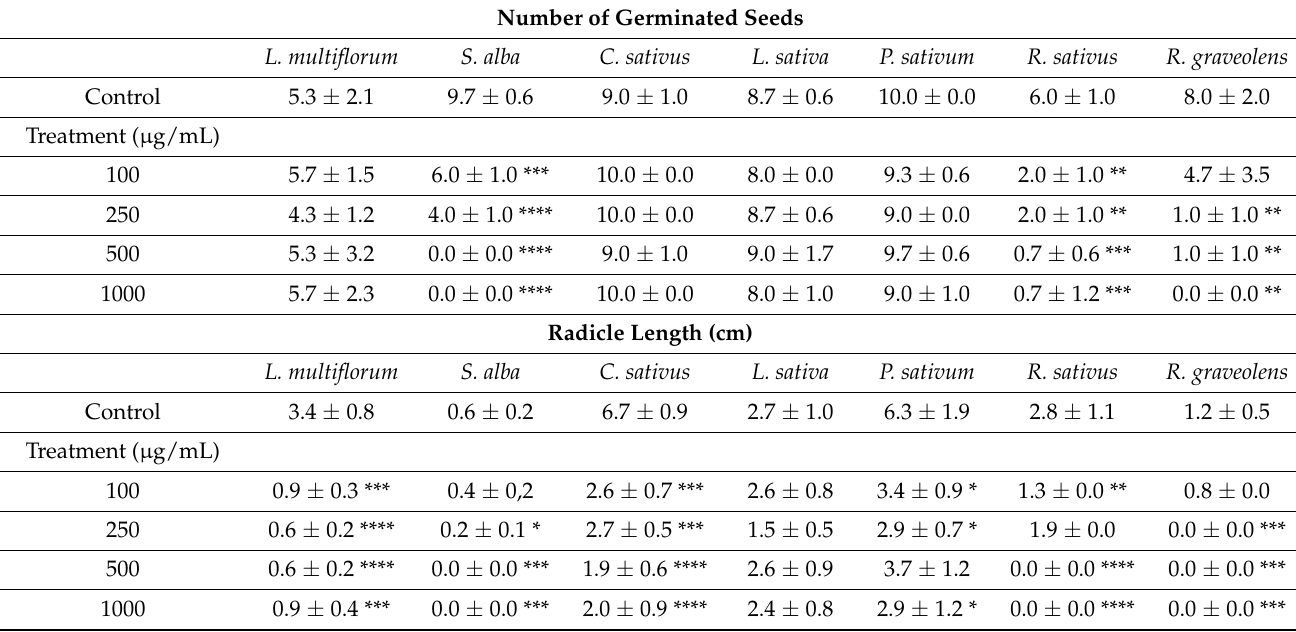
Table 4. Phytotoxic activity of the E. nicholii essential oil applied at different concentrations ( µ g/mL) to seeds of diverse plant species.